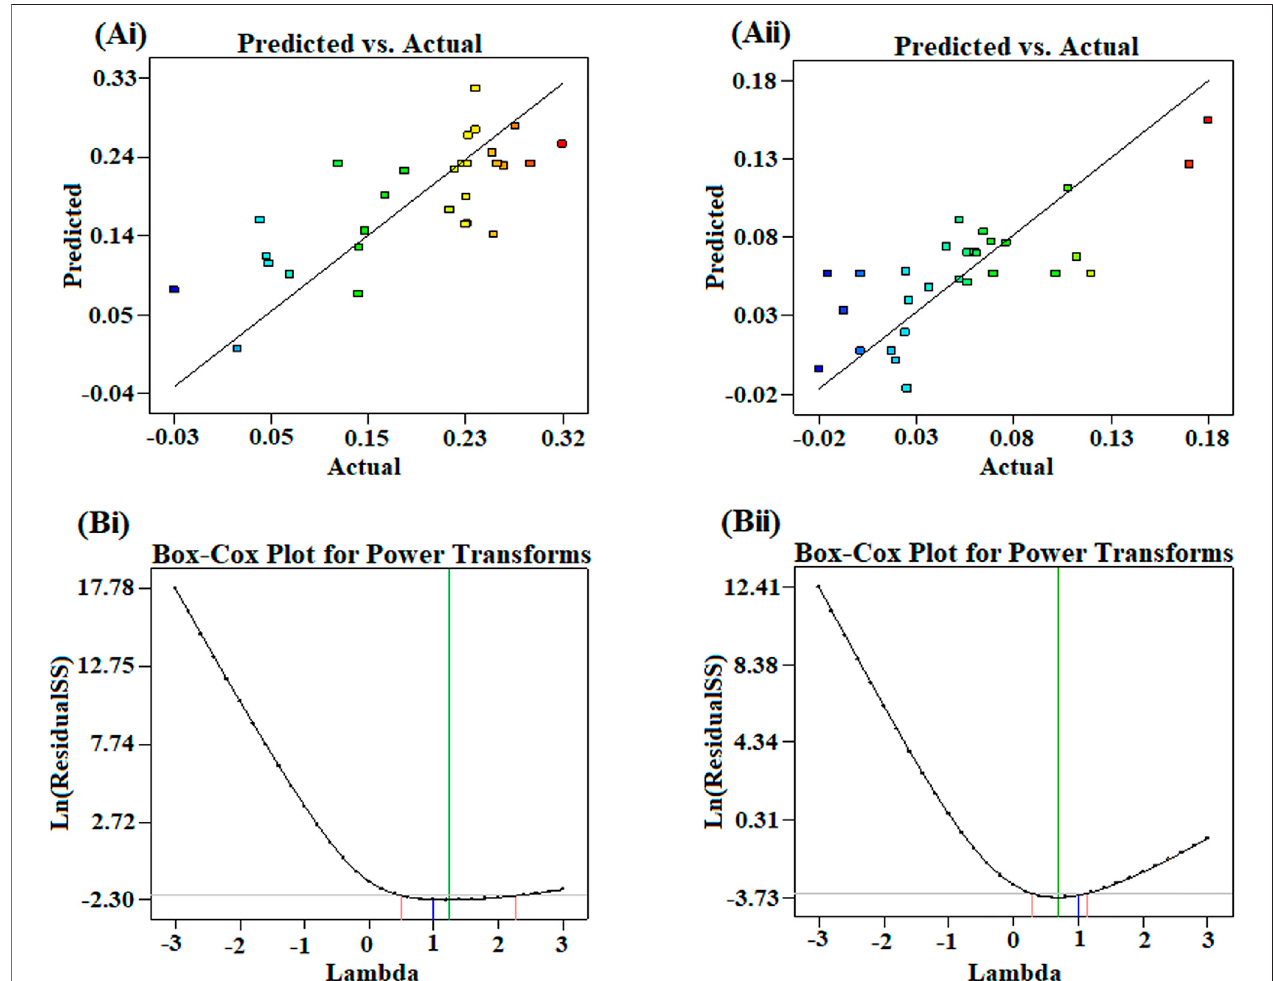
FIGURE 6 | Plots showing the correlation of actual conversions and values predicted by the model for (Ai) splenocyte proliferation and (Aii) pinocytic activity. Box – Cox plot showing optimized lambda for the transformation of (Bi) splenocyte proliferation and (Bii) pinocytic activity.